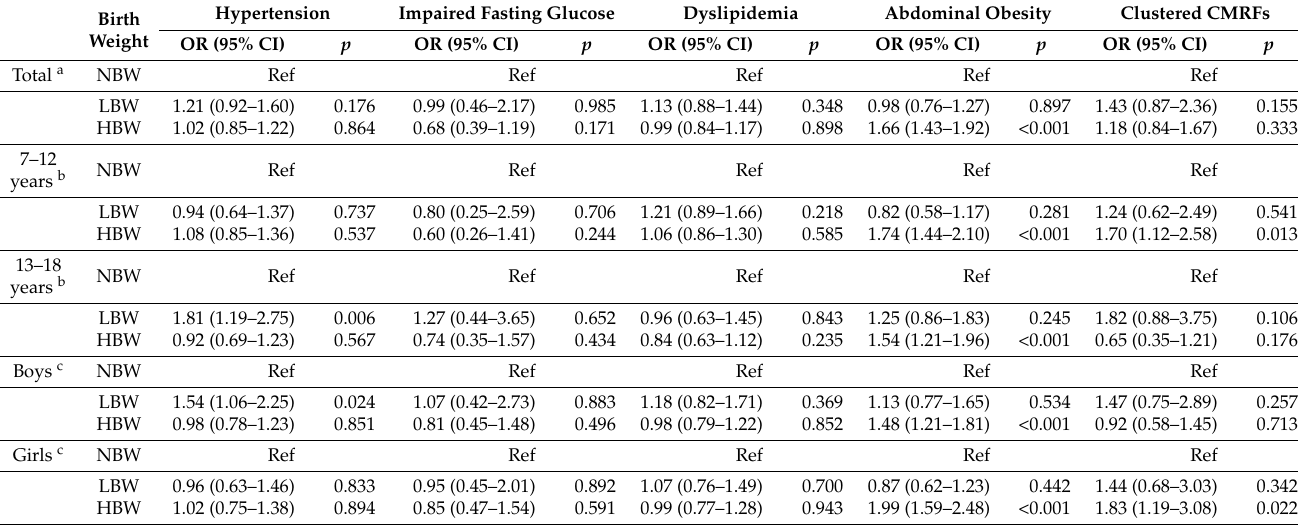
Table 3. Associations between CMRFs, clustered CMRFs and birth weight stratified by age and sex